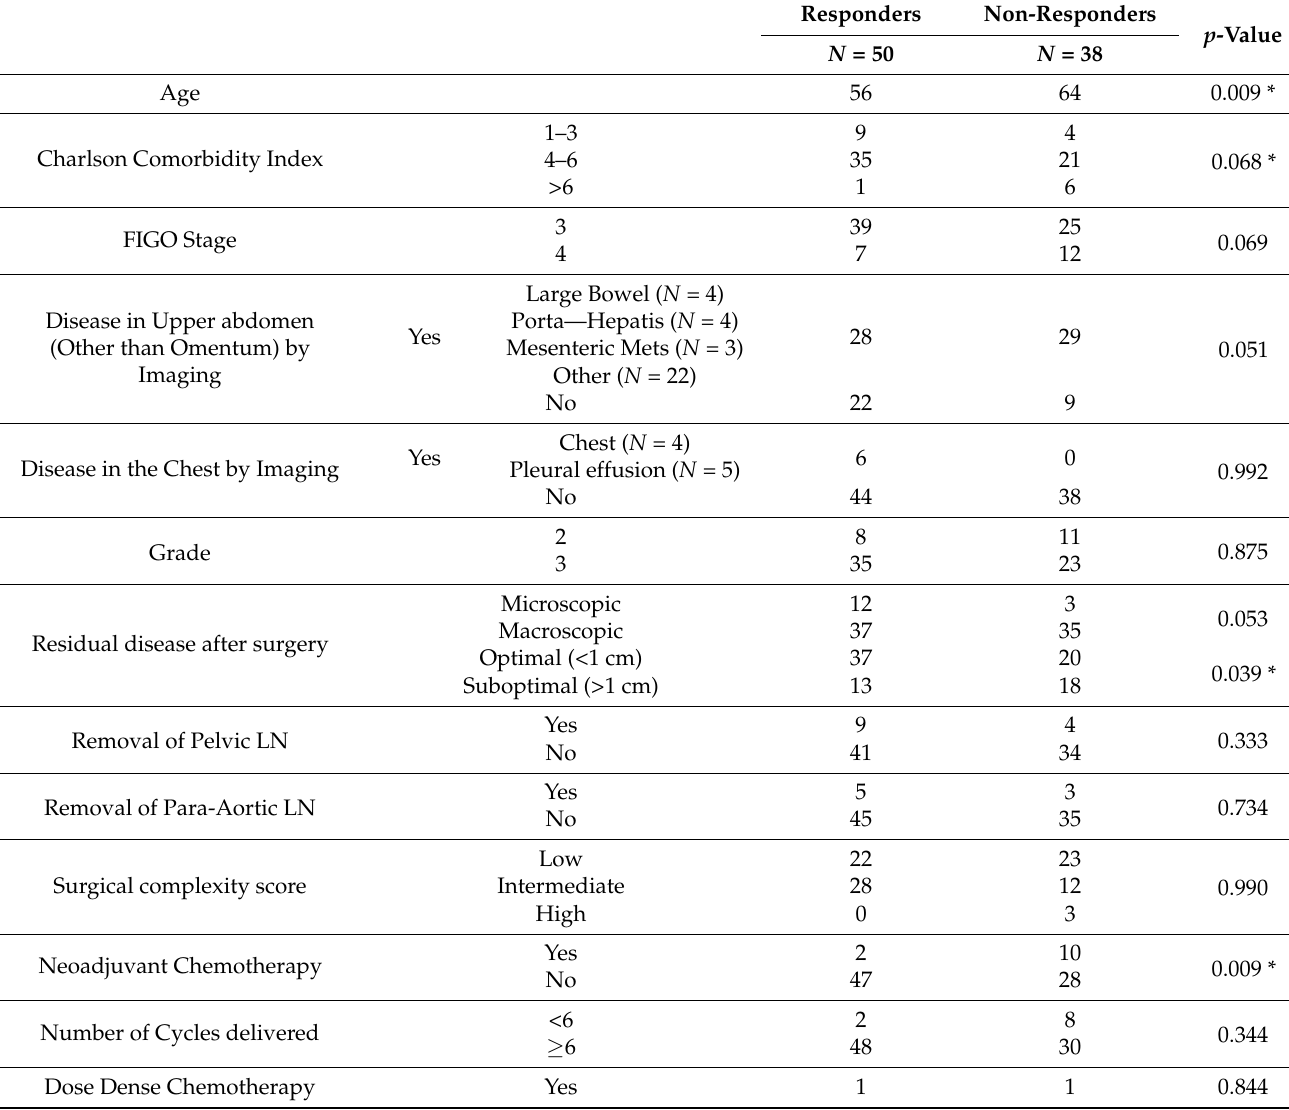
Table 3. Patient characteristics and association with chemo-response: Patients were divided between responders and non-responders based on definitions described in the methods. We had a total of 88 advanced-stage HGSC patients with clinical information regarding response to chemotherapy and a minimum follow-up of six months after treatment that were used for this analysis (Figure